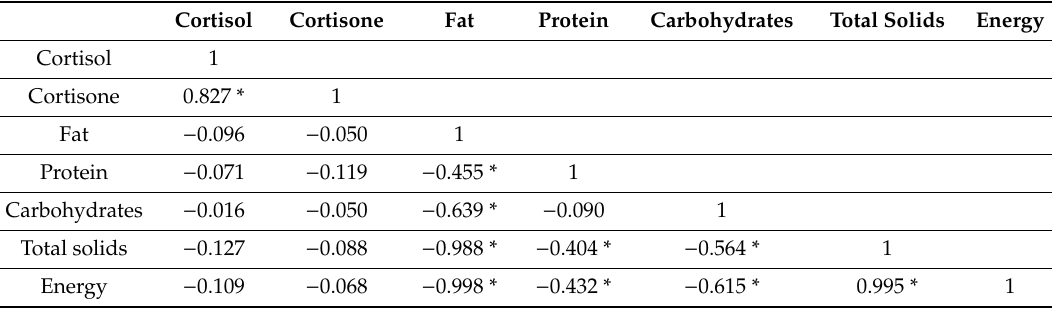
Table 1. Correlations between the milk glucocorticoids and macronutrients. Cortisol Cortisone Fat Protein Carbohydrates Total Solids Energy